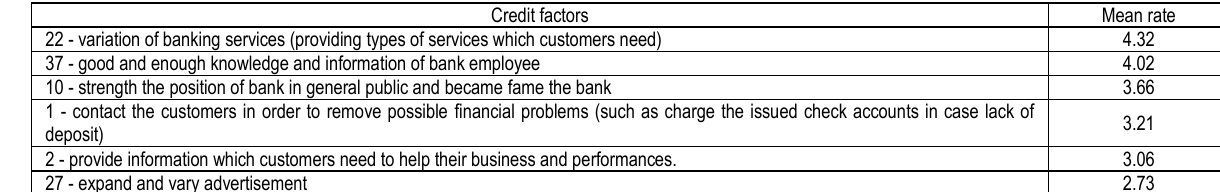
Table 5. Results of mean rate of credit factors based on priority